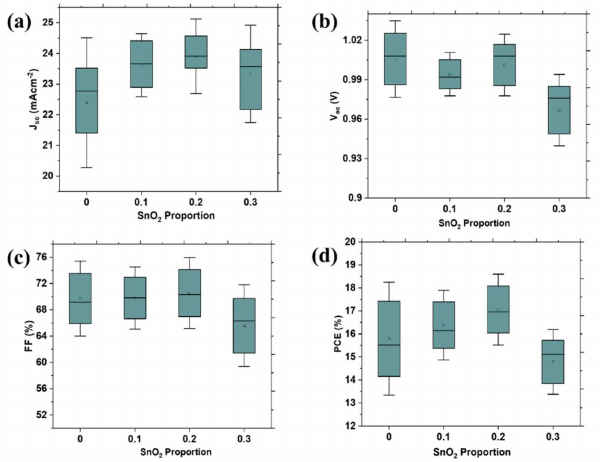
Figure 8. Box plots showing the variation of ( a ) J sc ( b ) V oc ( c ) FF and ( d ) PCE with SnO 2 content in the